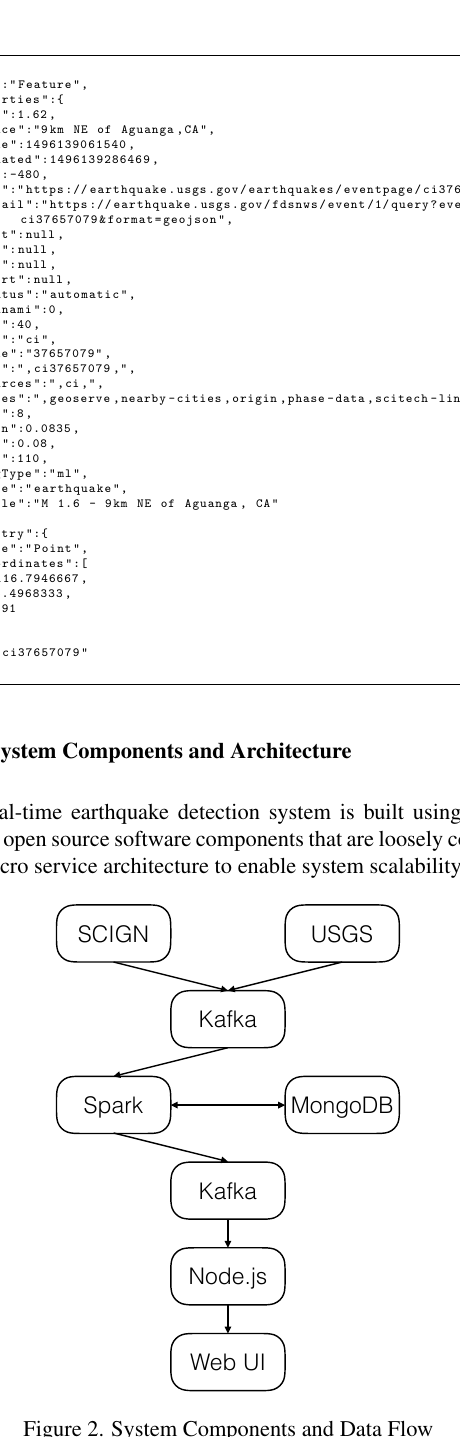
Figure 2. System Components and Data